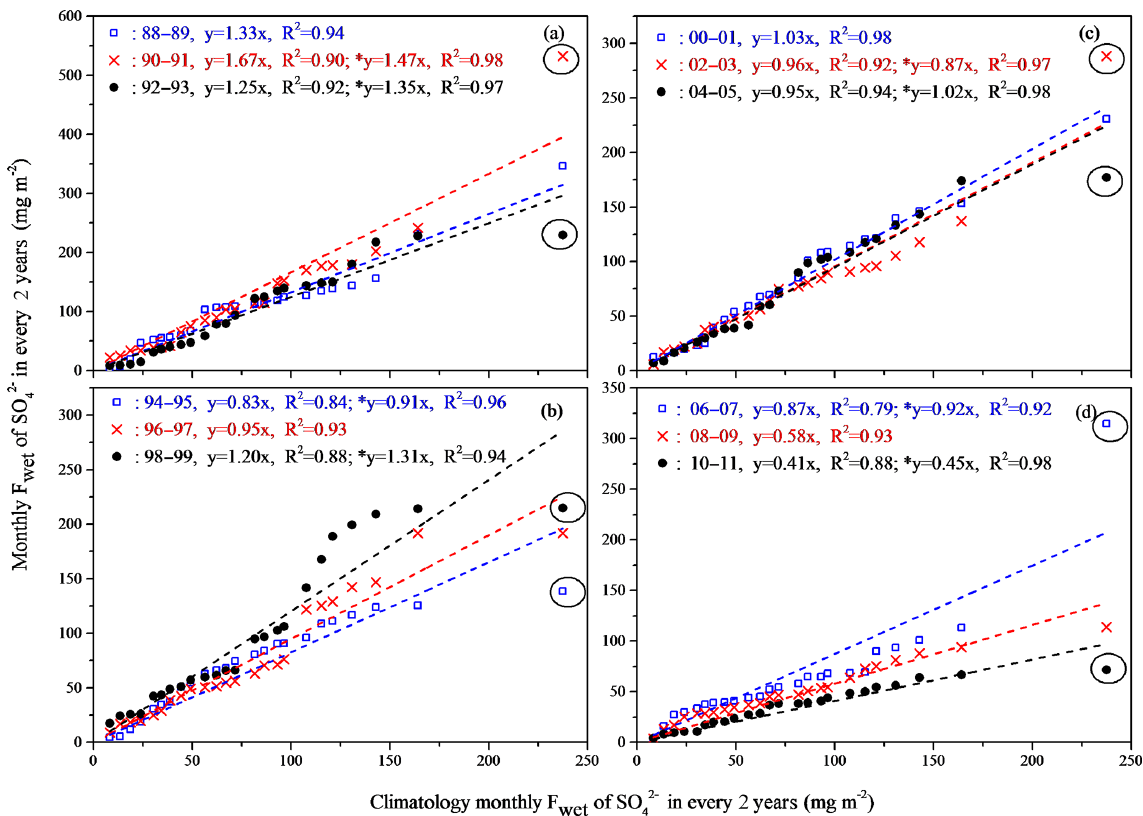
Figure 1. Fitting monthly F wet of SO 2 − against the climatology values from every 2 years using LR with zero interception at Site 1 according 4 to the new approach described in Sect. 2. Fitted lines represent the LR function with zero interception using 24 elements. x , y , and R 2 in the legend represent climatology monthly F wet , monthly F wet in every 2 years, and the coefficient of determination in LR analysis, respectively. The asterisk reflects the maximum value (cycled markers) excluded for LR analysis and all P values < 0 .